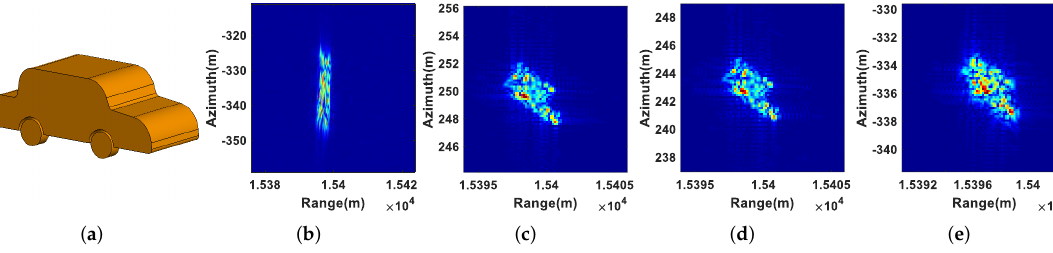
Figure 9. Refocusing results of T5: ( a ) shape of T5; ( b ) defocusing result; ( c ) refocusing result using the real 2D velocity; ( d ) refocusing result using the estimated 2D velocity; ( e ) refocusing result using the PGA algorithm.